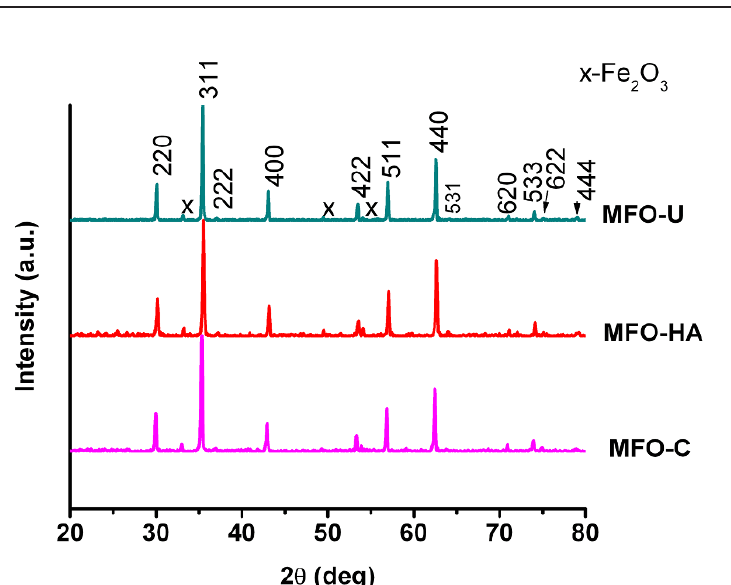
O powders retreated at 1173 K 9 2 4